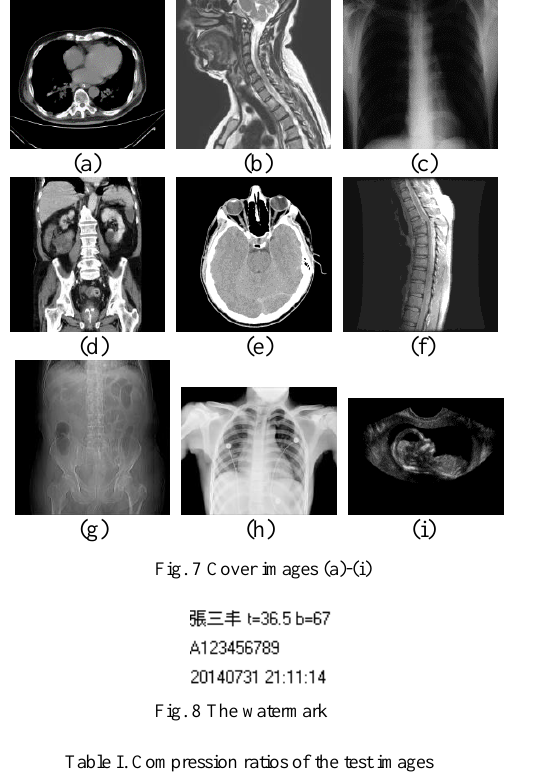
Table I. Compression ratios of the test images